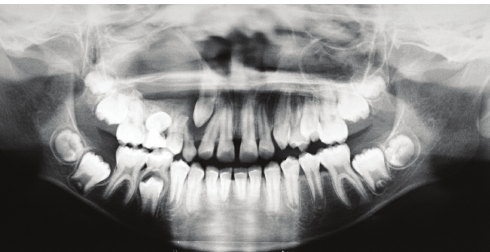
Figure1:Initialpanoramicradiography:retentionoftheupperright second premolar and upper right canine with increased pericoronal space, vertical impaction, and root dilaceration; root resorption of primary teeth; opacity of the right maxillary